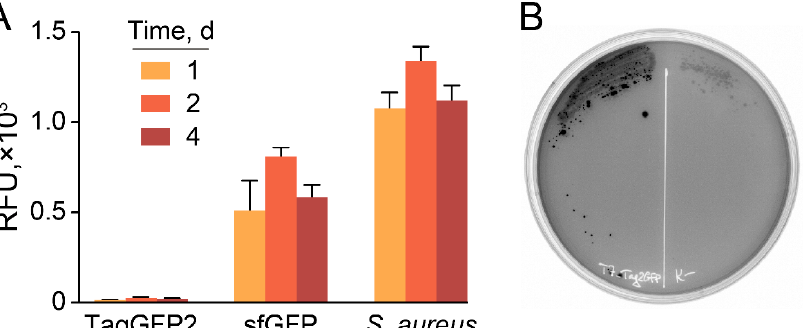
Figure 4. Hyperproduction of TagGFP2 fluorescent protein results in plasmid loss. ( A ) Fluorescence of cell cultures transformed with synonymous plasmids encoding TagGFP2 and sfGFP fluorescent proteins under the control of T7 promoter, induced by the addition of 1 mM IPTG. GFP-producing reporter S. aureus cells were used as a control. Data represent the mean of three biological replicates ± SD. ( B ) A representative plate with E. coli -producing TagGFP2 under control of T7 promoter, induced by 1 mM IPTG. Moreover, TagGFP2-producing plasmids based on T7 promoter tend to be lost under